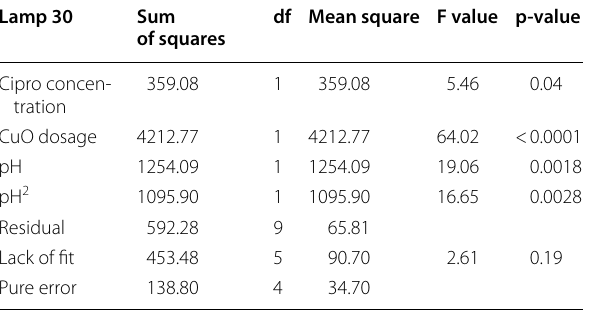
Table 5 Analysis of variance (ANOVA) results for the fitted polynomial model for COD removal using photocatalytic process with lamp 30-W